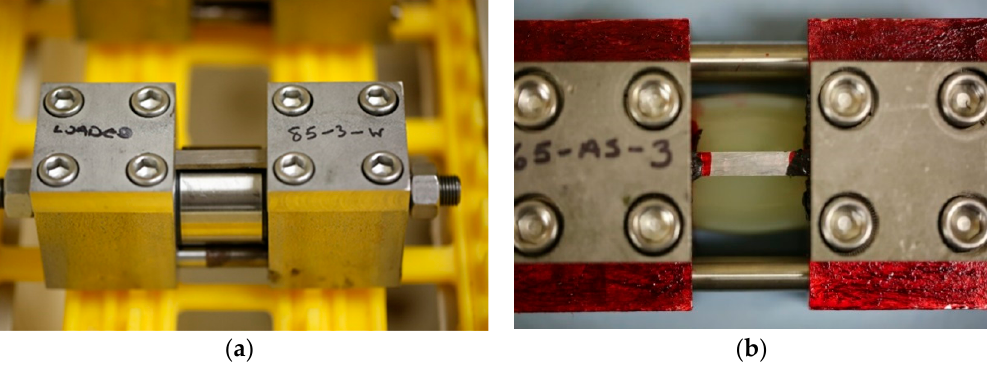
Figure 4. Corrosion-resistant uniaxial test fixture designed at PSU/ARL, used in SCC testing loaded with a sample ( a ) before coating to prevent galvanic couple and ( b ) after coating with STOP-OFF lacquer.